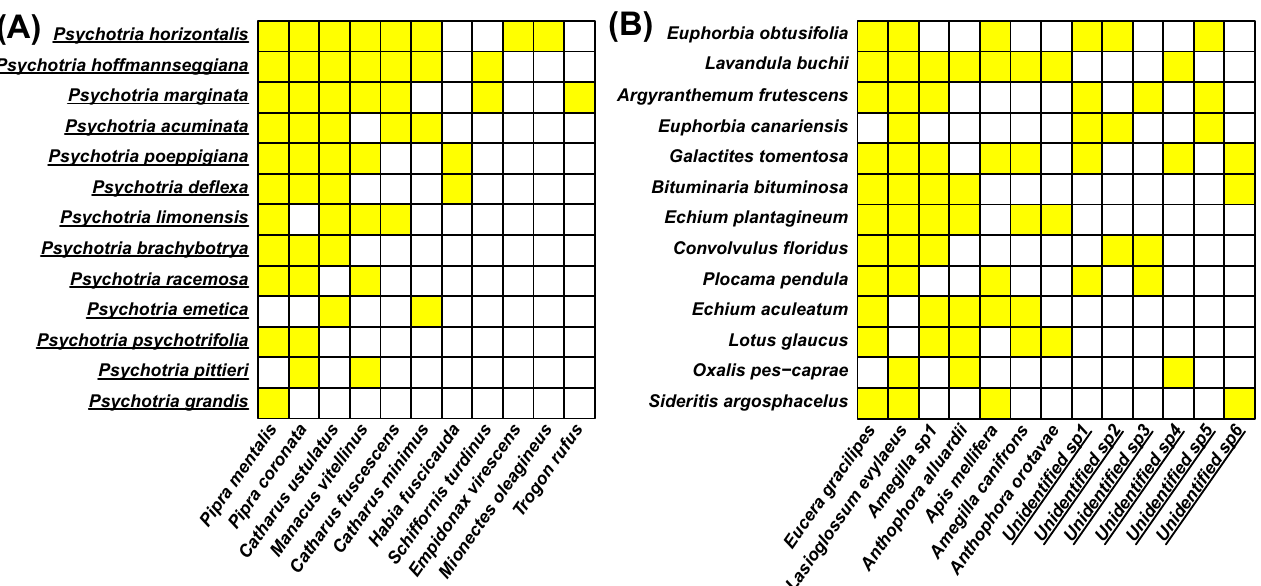
Fig 2. Matrix representations of 2 bipartite species interaction networks from www.web-of-life.es; an open species interaction network database. Yellow boxes in each matrix indicate the presence of an interaction between species at the corresponding row (plants) and column (animals). (A) Seed-dispersal network from Poulin and colleagues (1999) [41], where all plant species (underlined) are from the genus Psychotria . (B) Subset of the plant–pollinator network from Stald (2003) [42], which includes a large number of unidentified pollinator species (underlined; 34 of the 54 total pollinator species (not all shown here) in the whole